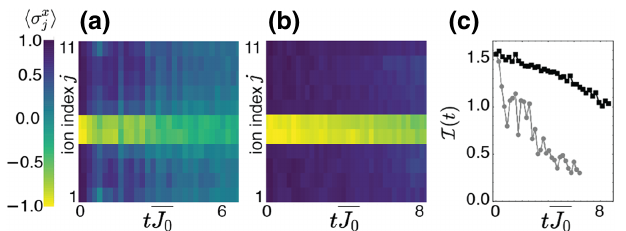
FIG. 4. The performance of dynamical decoupling to preserve trivial evolution under a many-body Hamiltonian. Ions are ini- tialized as either up or down along x and a long-range spin-spin Hamiltonian H XX is applied for variable time, with and without CPMG decoupling pulses, before the x magnetization is read out. In the absence of decoupling, stray ac Stark shifts induce dynam- ics and dephasing, while with decoupling these are suppressed. The parameters are δ/η(cid:6) = 7.5, t p = 20 µ s, and t 1 = 120 µ s. The evolution time is scaled by the nearest-neighbor spin-spin coupling averaged over the pulse sequence, J 0 . (a),(b) The aver- age magnetization of individual spins: (a) regular sequence; (b) decoupled sequence. (c) The generalized imbalance I ( t ) , mea- suring preservation of the initial state (see text), for a regular sequence (gray) and a decoupled sequence (black). The points are the average of 500 experimental repetitions, with error bars smaller than the symbol size.